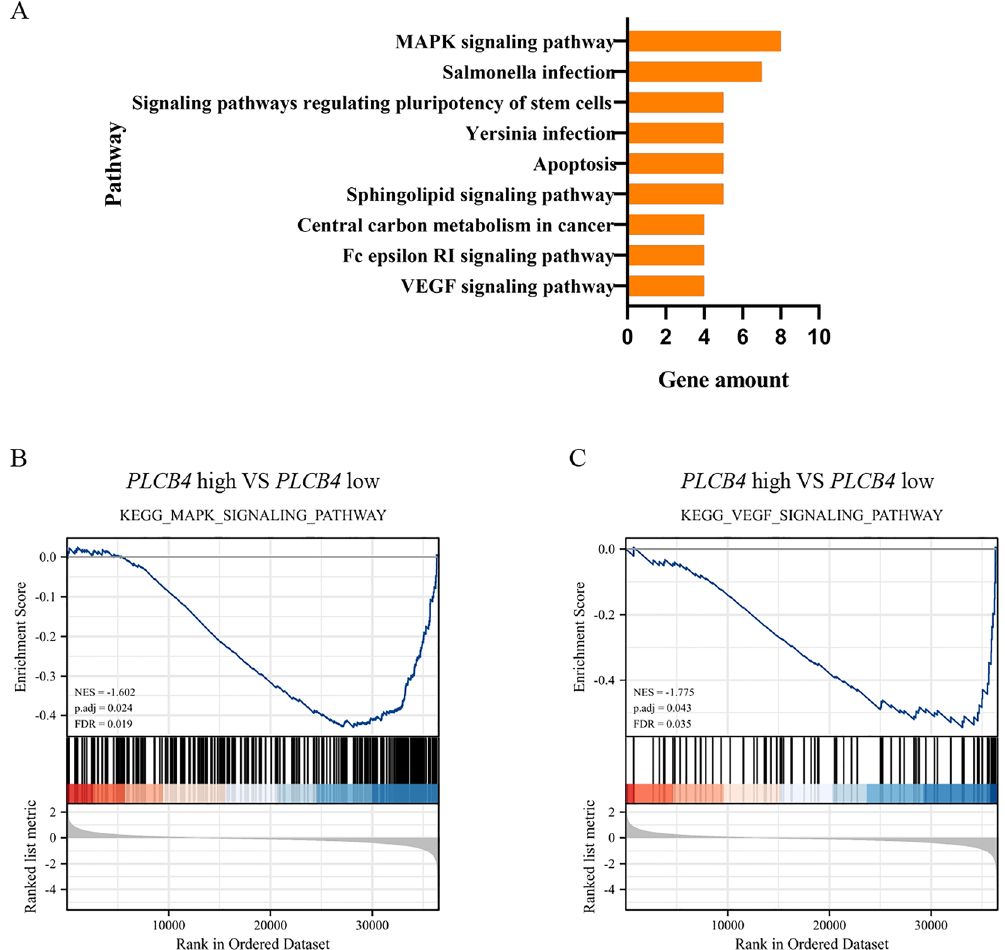
Figure 8. Enrichment analysis of PLCB4 in colorectal cancer. ( A ) KEGG pathway analysis of top 100 negatively co-expressed genes of PLCB4 in colorectal cancer identified using the cBioPortal database. GSEA analysis between high (top 50%)—and low (bottom 50%)— PLCB4 expression using the TCGA COAD data. PLCB4 low expression group was enriched in the ( B ) MAPK Signaling pathway and ( C ) VEGF signaling